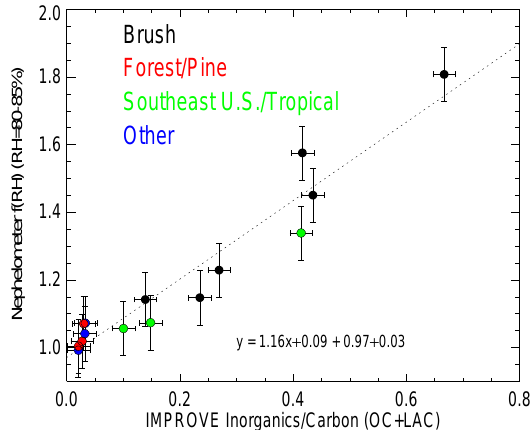
are plotted by number (see Table 2) and type (color). Experimental uncertainties (±0.08)